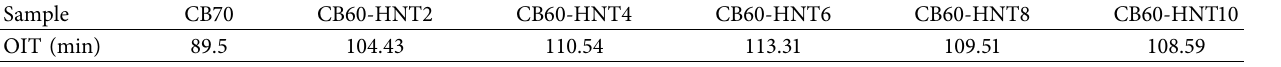
Table 2: OIT values of ACM composites at 200 ° C.